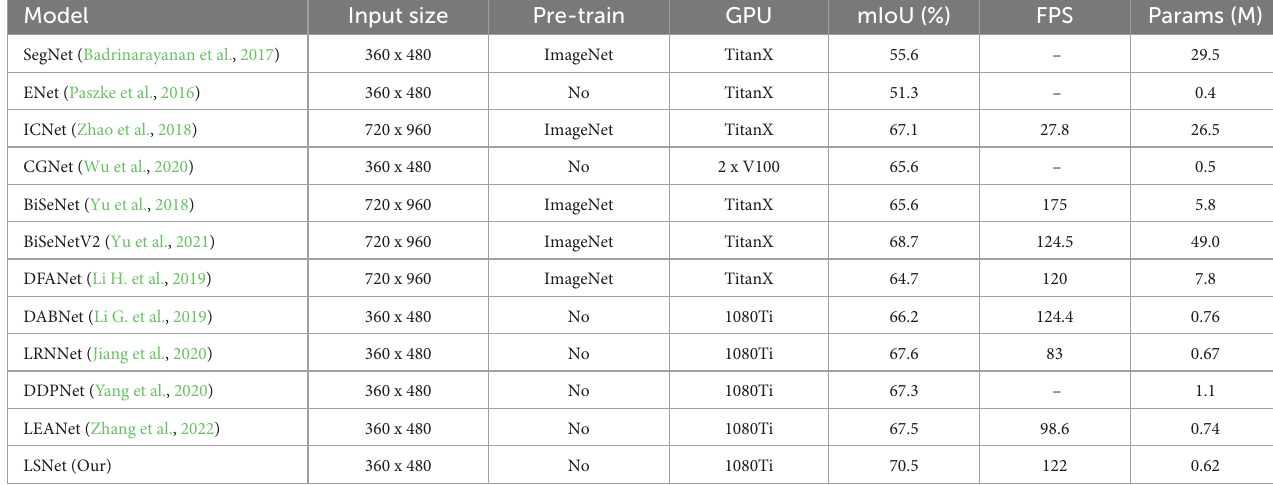
TABLE 5 Evaluation results of our lightweight semantic segmentation network (LSNet) and other state-of-the-art real-time semantic segmentation models on the CamVid test set.